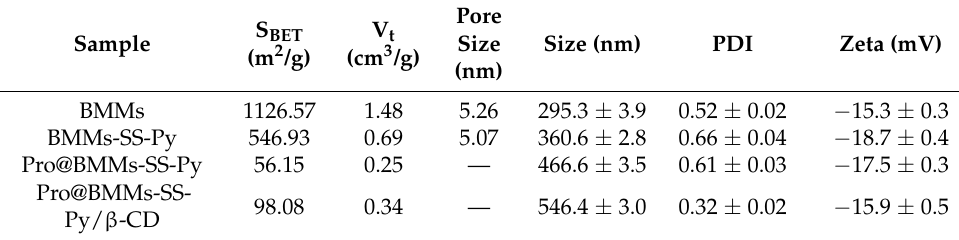
Table 1. Mesoporous structure characterization, size, and zeta potential of samples.